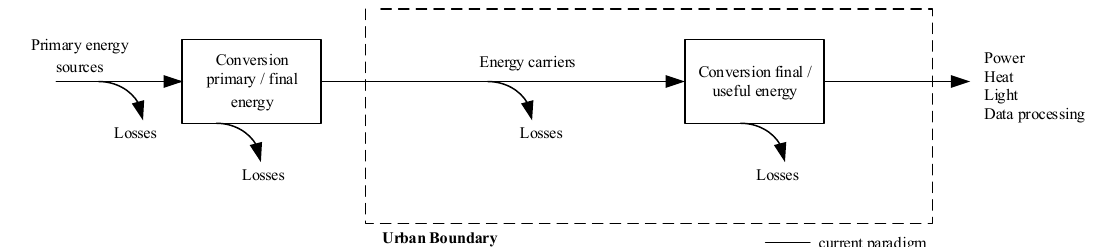
Figure 4. The current energy model of Cuenca.